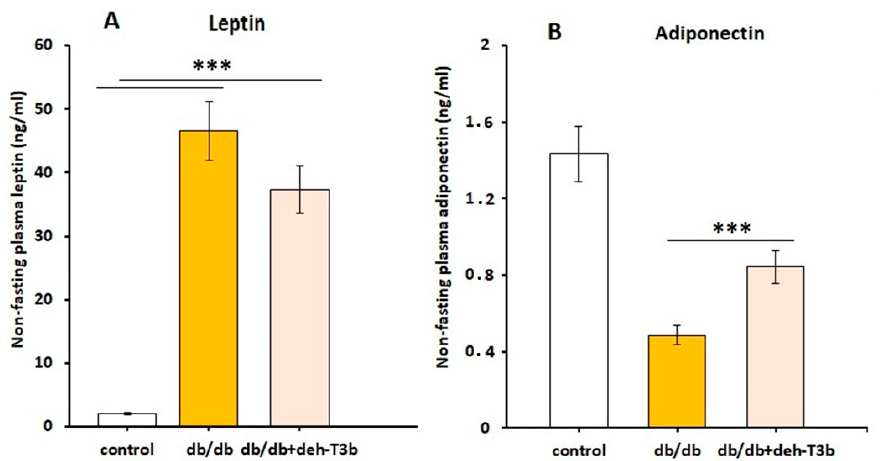
Figure 16. Leptin ( A ) and plasma levels of adiponectin ( B ) in control C57BL6 mice and db/db mice after two weeks’ treatment with chow or deh-T3 β mixed with the diet. Values are means ± SEM of three independent experiments, *** p <